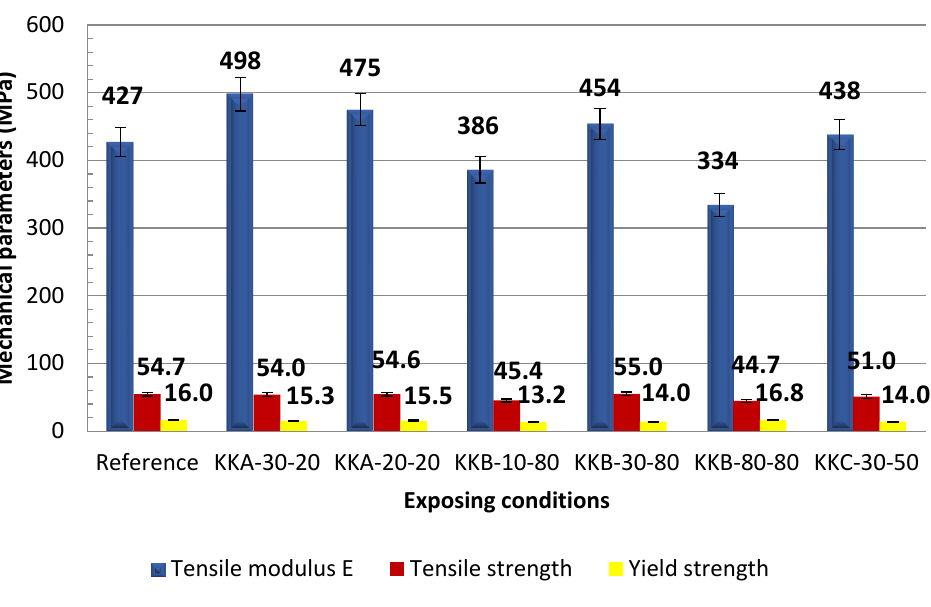
Figure 15. Mechanical parameters of samples tested in the climatic chamber.